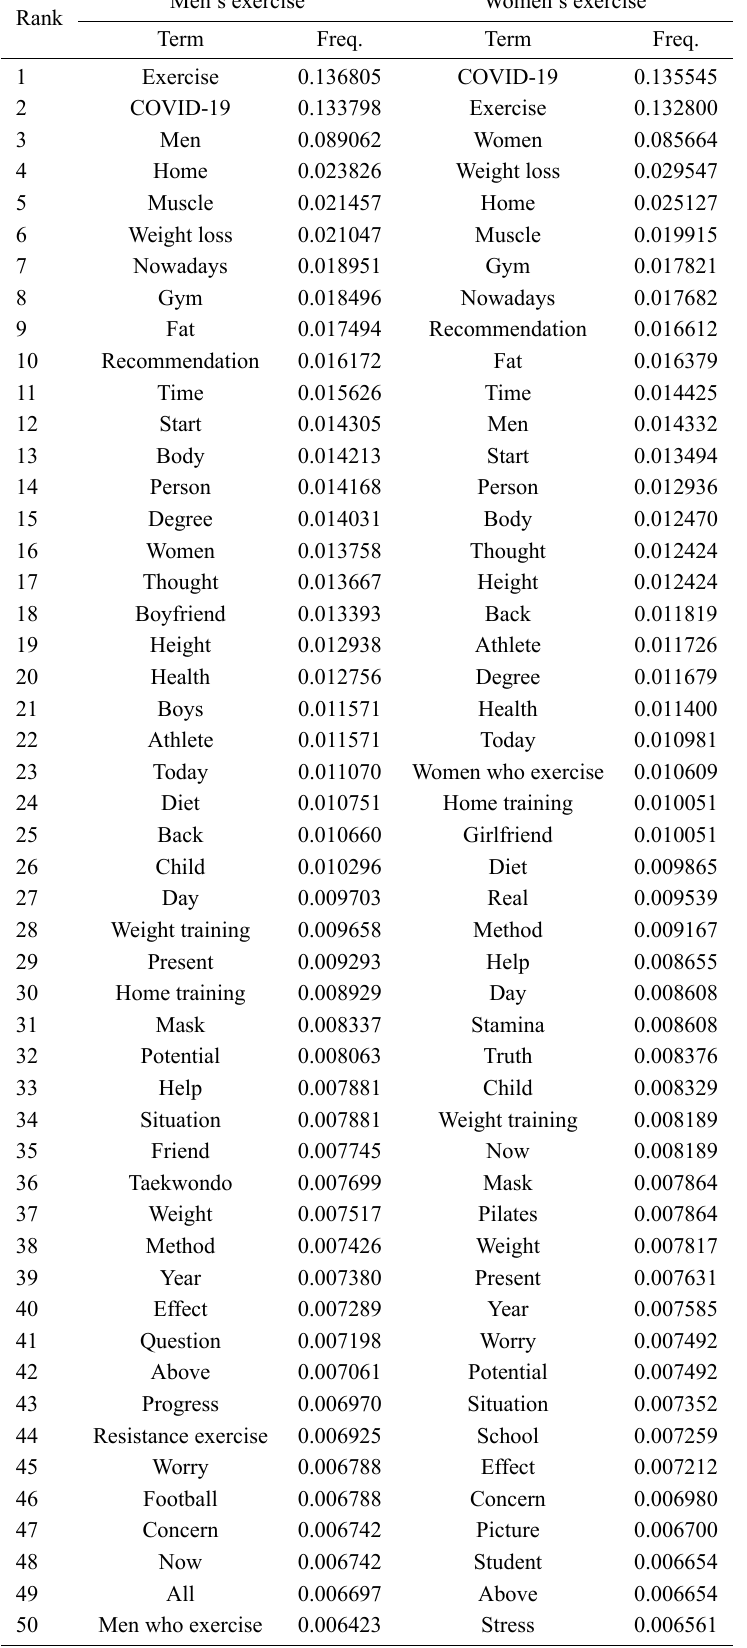
Table 5. Results of the degree centrality